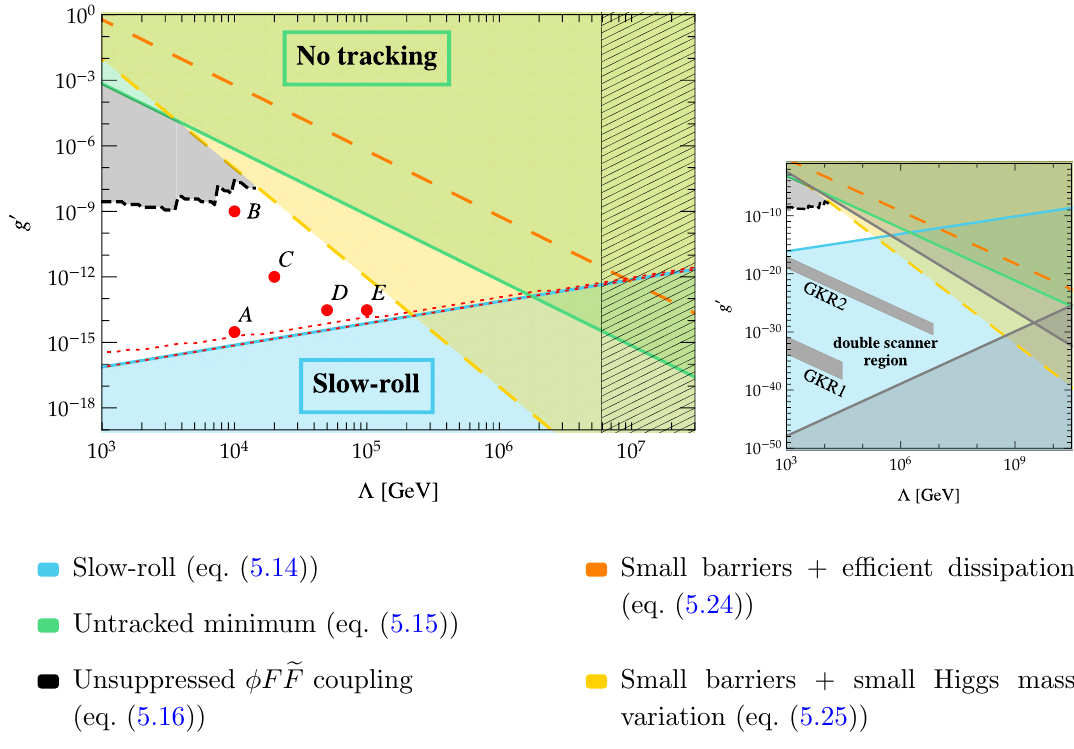
Figure 8 . Summary of the available region of parameter space in the g 0 (cid:0) (cid:3) plane consistent with the relaxion mechanism exploiting particle production instead of in(cid:13)ation. Constraints come from eqs. (5.14){(5.16), (5.24) and (5.25). The red dots correspond to the (cid:12)ve benchmark cases of (cid:12)gure 9. The dashed lines correspond to the bounds which rely on conservative assumptions about the thermalisation process. The region between the red dotted lines corresponds to the one in which the in(cid:13)aton is allowed to reheat the SM before relaxation takes place (see (cid:12)gure 3). The rectangular hashed region at large (cid:3) is the one in which the approximation of instantaneous particle production fails. Right plot: this smaller plot indicates in comparison the parameter space